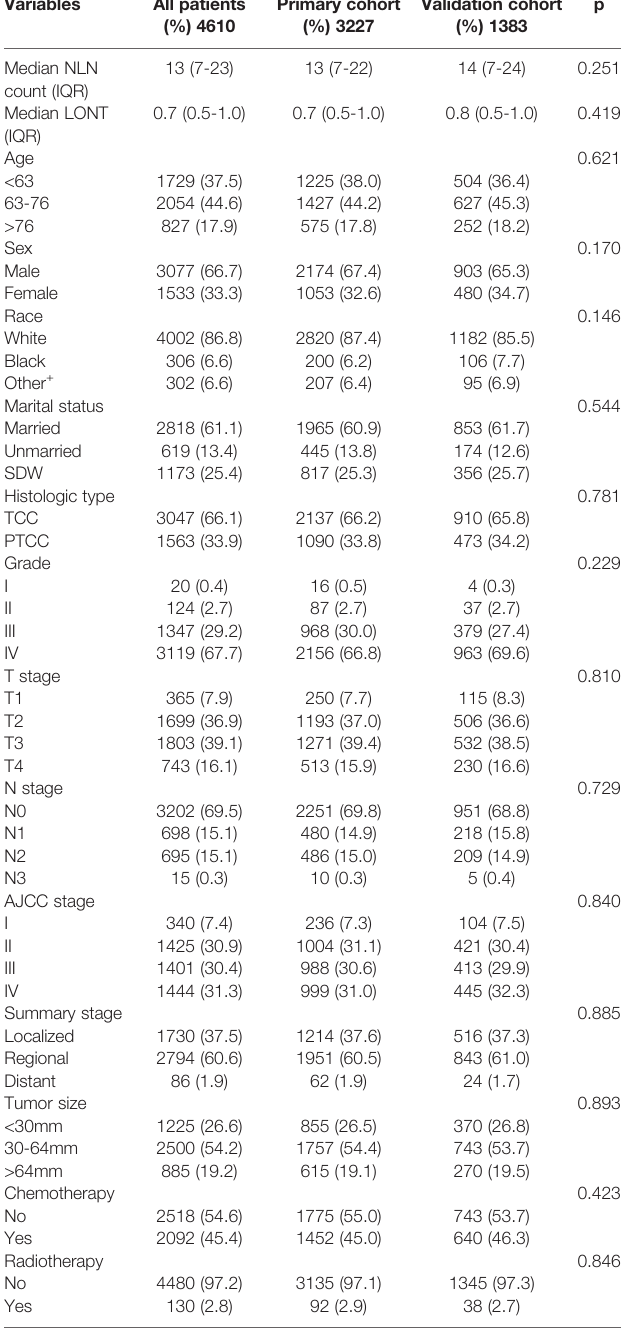
NLNs, negative lymph nodes; ELNs, Examined lymph nodes; LONT, Log odds of negative lymph nodes/T stage; IQR, interquartile range; Other + American/Indian/Alaska/Native/ Asian/Paci fi c Islands; SDW separated, divorced or widowed; TCC, Transitional cell carcinoma; PTCC, papillary Transitional cell